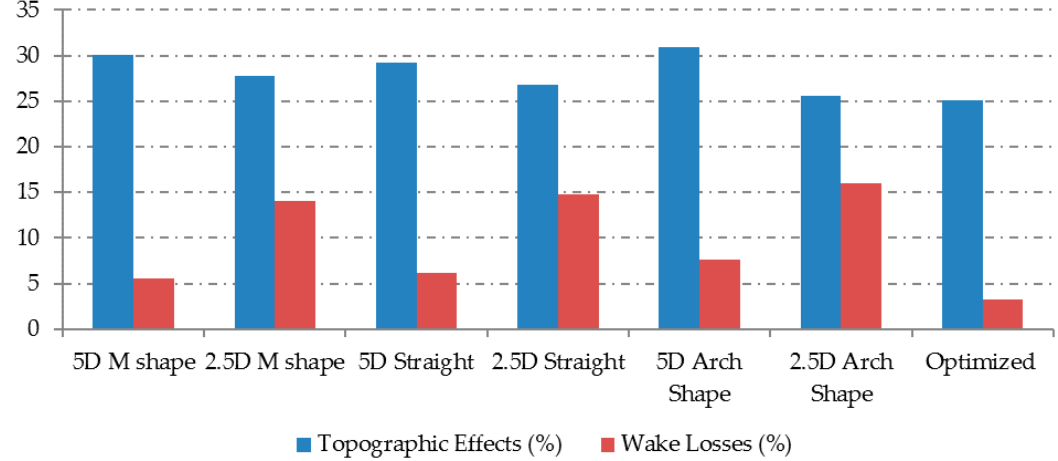
Figure 11. Topographic e ff ects and wake losses of six layouts and optimized arrangement of the wind turbines.